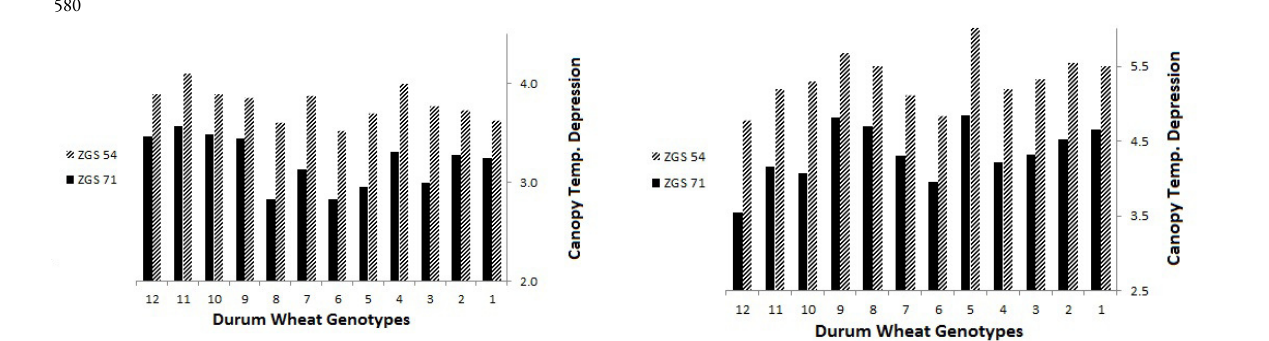
Fig. 3. Canopy temperature depression values of durum wheat genotypes in rain-fed condition